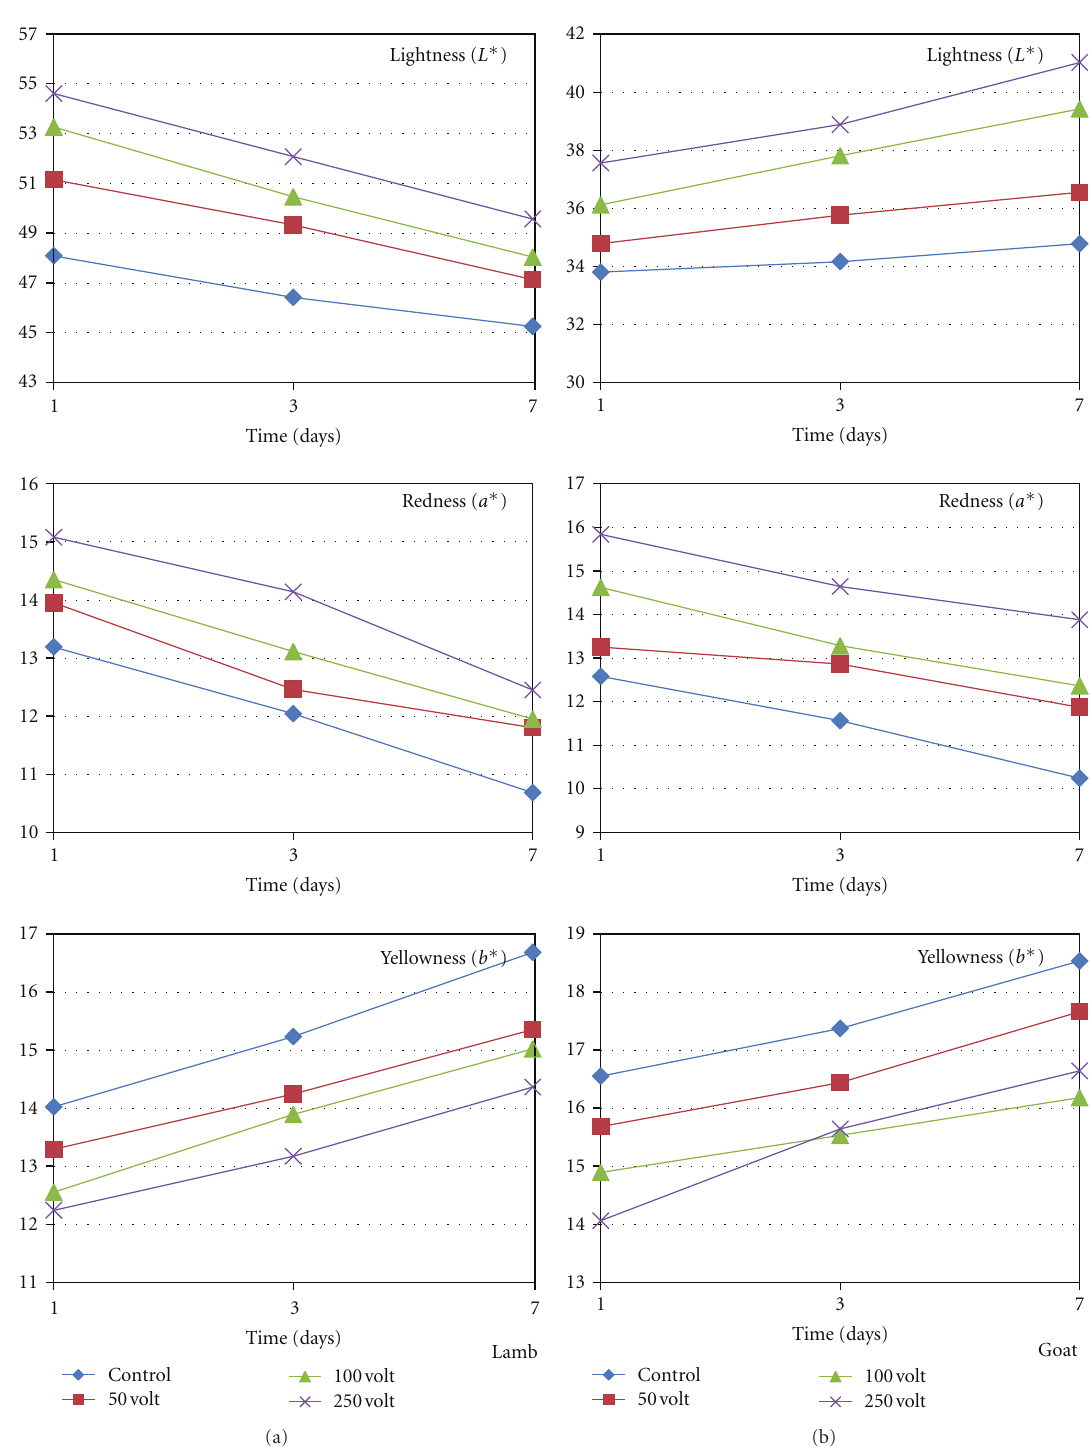
Figure 1: Instrumental colour (CIE L ∗ , a ∗ , b ∗ ) of lamb and goat meat aging at 4 ◦